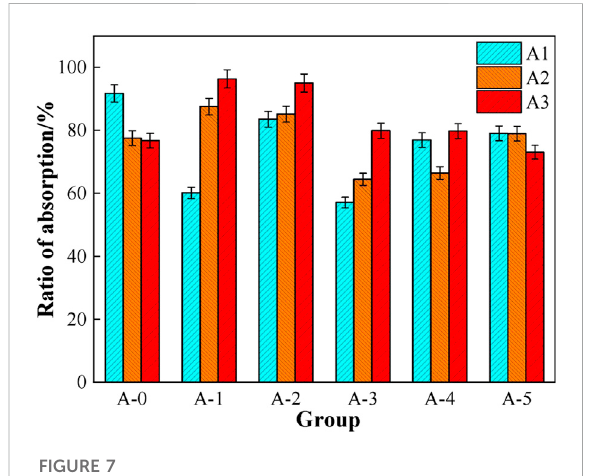
FIGURE 7 Effect of sodium alginate on the water absorption ratio of microbial repair materials.